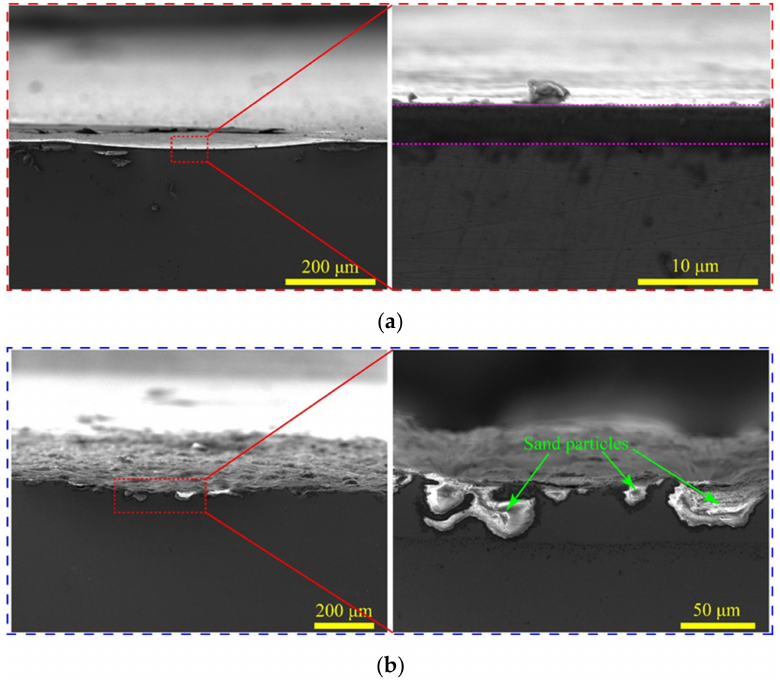
Figure 13. Cross-sectional SEM image of wear scar of CrAlN coating at 500 ◦ C. ( a ) No sand, and ( b )